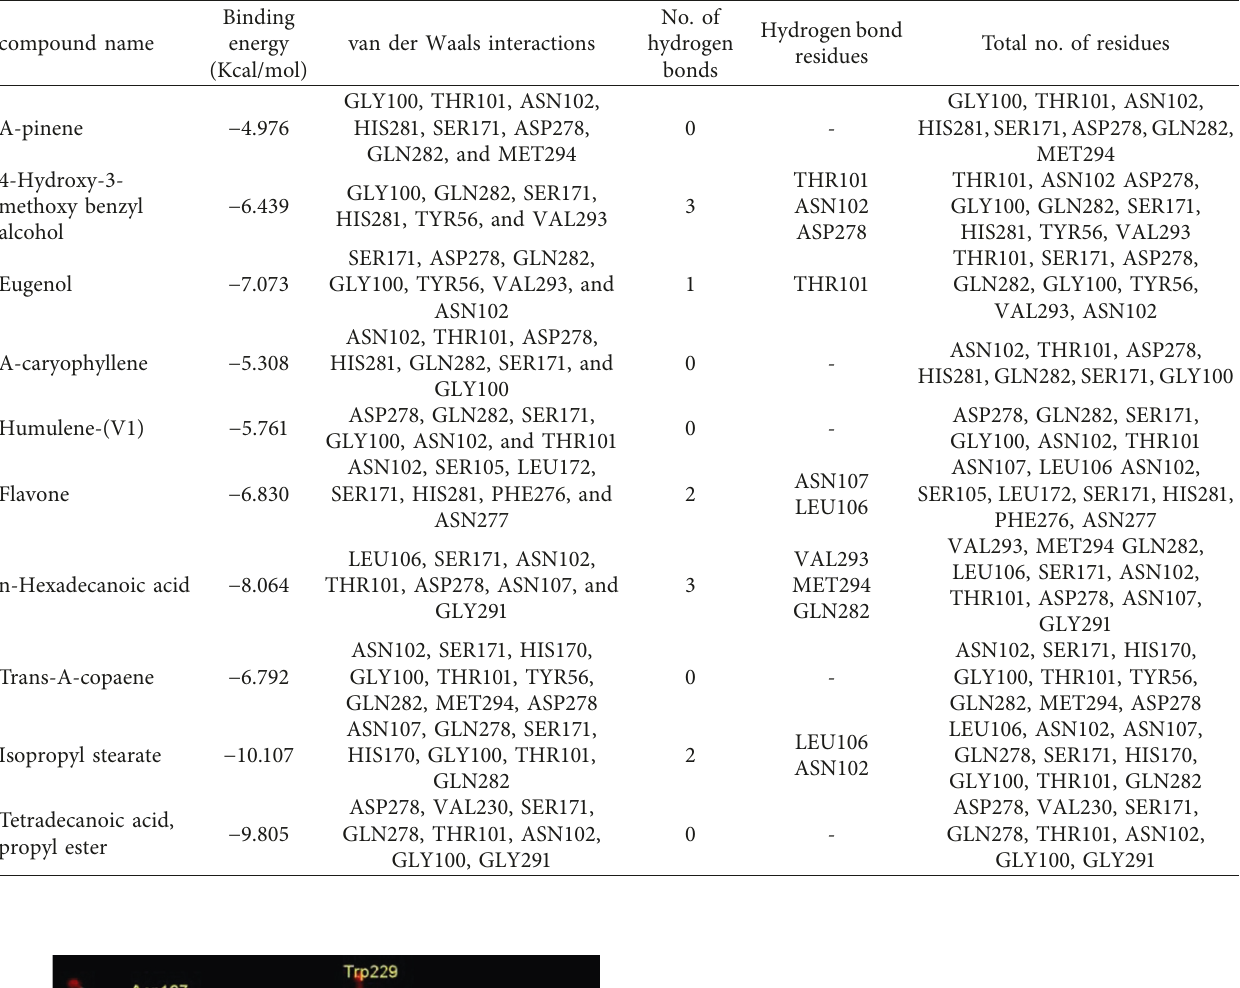
Table 3: Docked conformation of bioactive compounds against the lipase of Malassezia globosa.